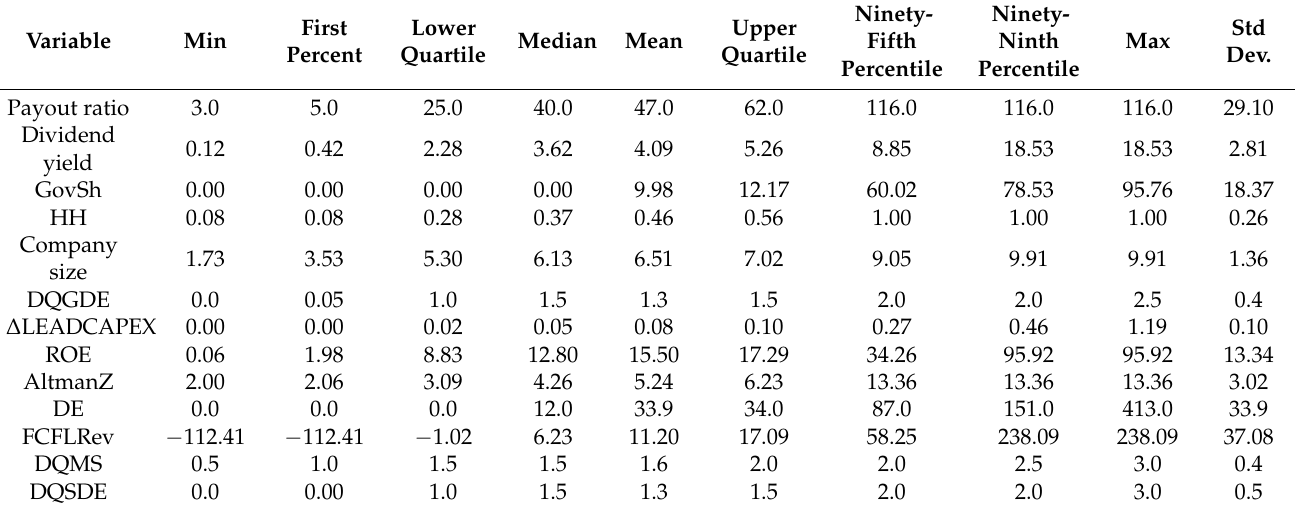
Table 1. Univariate descriptive statistics—continuous